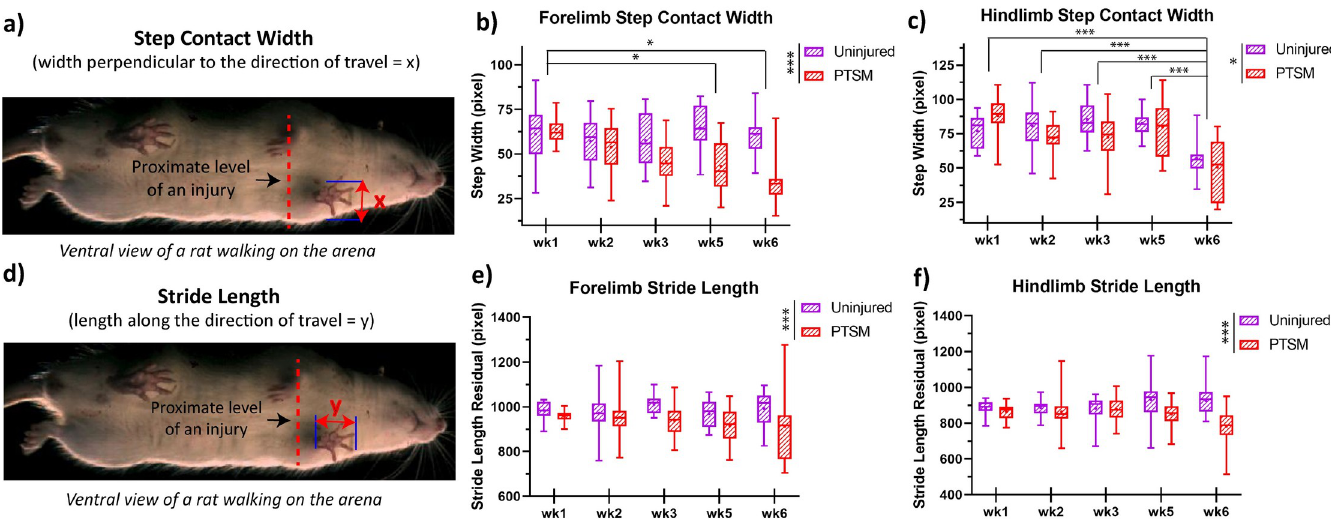
Fig 5. PTSM injury affects step contact width and stride width. a) The definition of step contact width depicted pictorially. b) Hindlimb as well as c) forelimb step contact width was altered due to PTSM injury. d) Definition of stride length. PTSM injury disturbed the hindlimb e) and forelimb f) stride length. For all graphs, data are presented as mean ± standard error for the uninjured group n = 6, and PTSM group n = 9, for both groups subsamples (videos) s = 4 to 6. � denotes p < 0.05, �� denotes p < 0.01, ��� denotes p < 0.005, ���� denotes p < 0.001 represents statistical significance as determined by the mixed-effect model with Tukey’s post hoc ( p < 0.05).